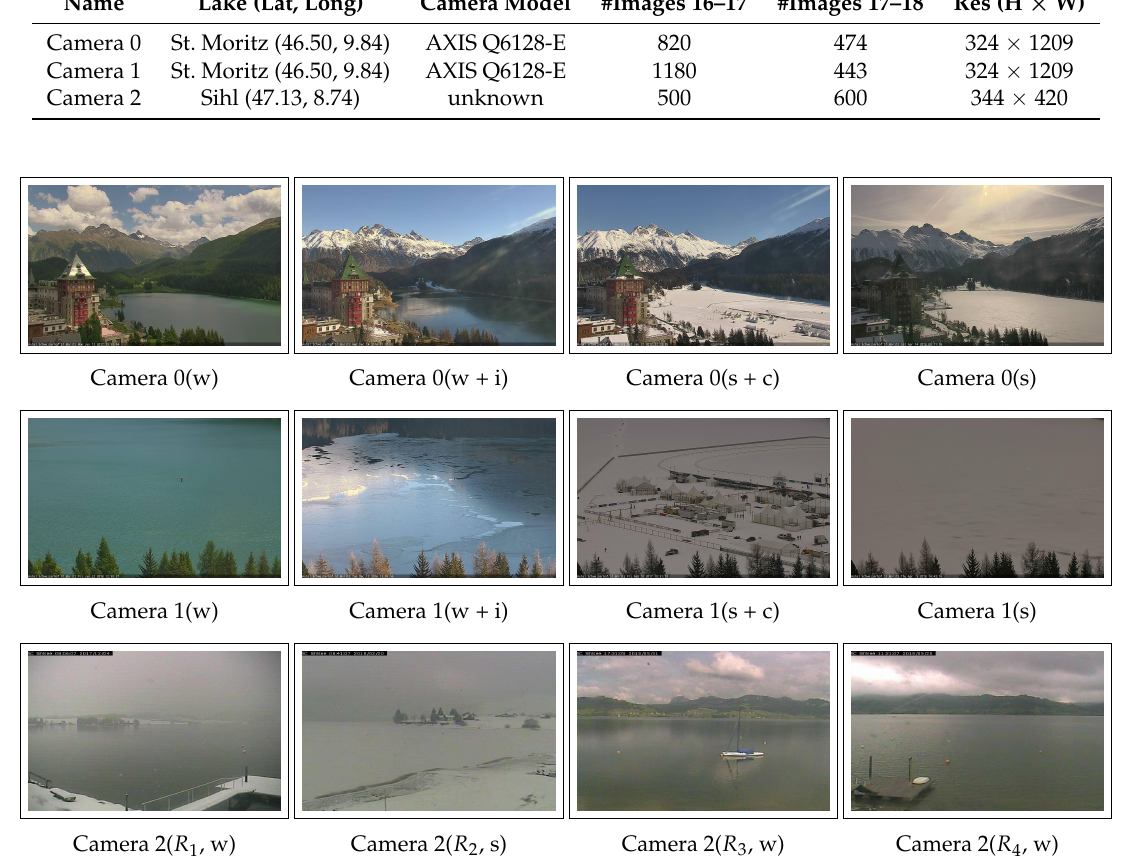
Figure 5. Photi-LakeIce dataset. Rows 1 and 2 display sample images from cameras 0 and 1 (St. Moritz) respectively. Row 3 shows example images of camera 2 (Sihl, non-stationary, and some rotations [ R 1 , R 2 , etc.] are also displayed). State of the lake: water(w), ice(i), snow(s), and clutter(c) is also displayed in brackets.